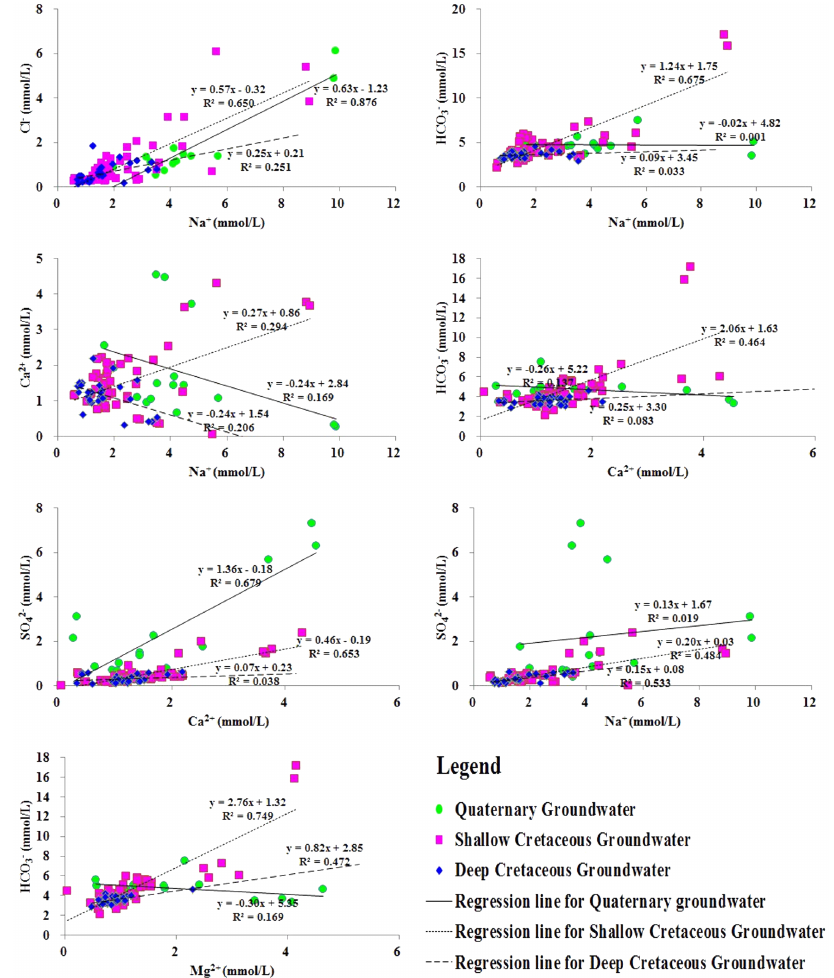
Figure 8. Relationship between some pairs of ions in